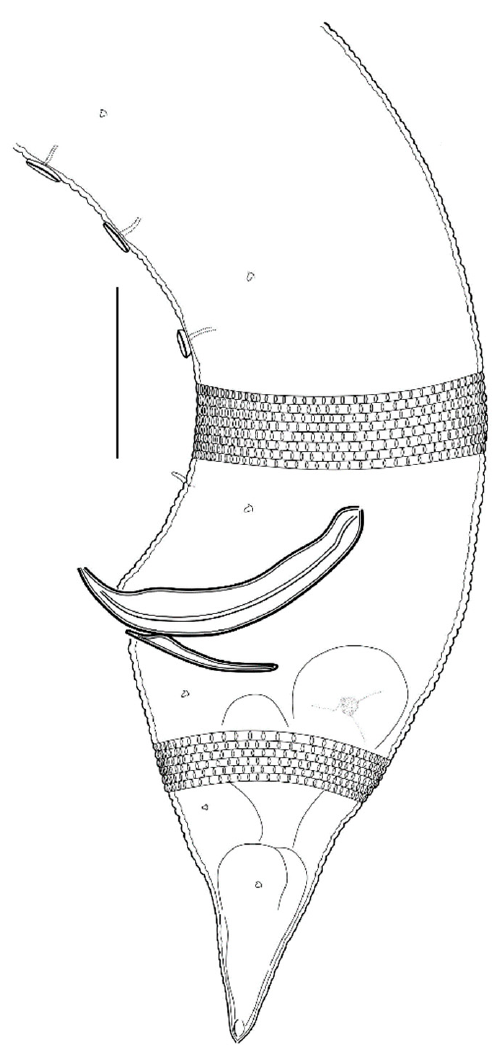
Figure 7. Gammanema okhlopkovi sp. n., posterior body of the holotype male. Scale bar: 20 µ m. The mouth opening is situated on the bottom of a funnel-shaped depression on the truncate anterior end. Acute teeth arranged in three radiating groups are visible, even in a semi-open mouth. Cheilostome is narrow and indistinct. Pharyngostome consists of two chambers. Anterior chamber is cup-shaped. Its walls are strengthened by three sclerotized rhabdions terminating posteriorly, with a group or five small cusps or denticles projected freely into the buccal cavity. The anterior rhabdions spread widely, thus making the anterior chamber bowl-shaped. In each group, the median tooth is tridentate, while teeth of two lateral pairs are bidentate. Posterior chamber cylindrical and narrow; its walls are strengthened by three sclerotized rhabdions. Pharynx cylindrical and evenly strongly muscular along its entire length. Reproductive system is diorchic. Anterior outstretched testis situated ventrally to the intestine; posterior reflexed testis situated to the right of the vas deferens and intestine. Spicules paired, arcuate, distally pointed, and proximally very slightly cephalated. Gubernaculum as paired, nearly straight bars directed dorsally. Midventral supplementary organs, ten to thirteen in number, shaped as a nail-head 5–6 µ m in diameter; the posteriormost organ situated at a distance 39 µ m from the cloacal opening. A short conical midventral precloacal seta is present. Table 3. Morphometrics of males Gammanema okhlopkovi sp. n. (holotype and paratypes). Tail very short; its conical tip turned left in all the Total Min.–Max. CV% Character Holotype Number Body length pharynx length